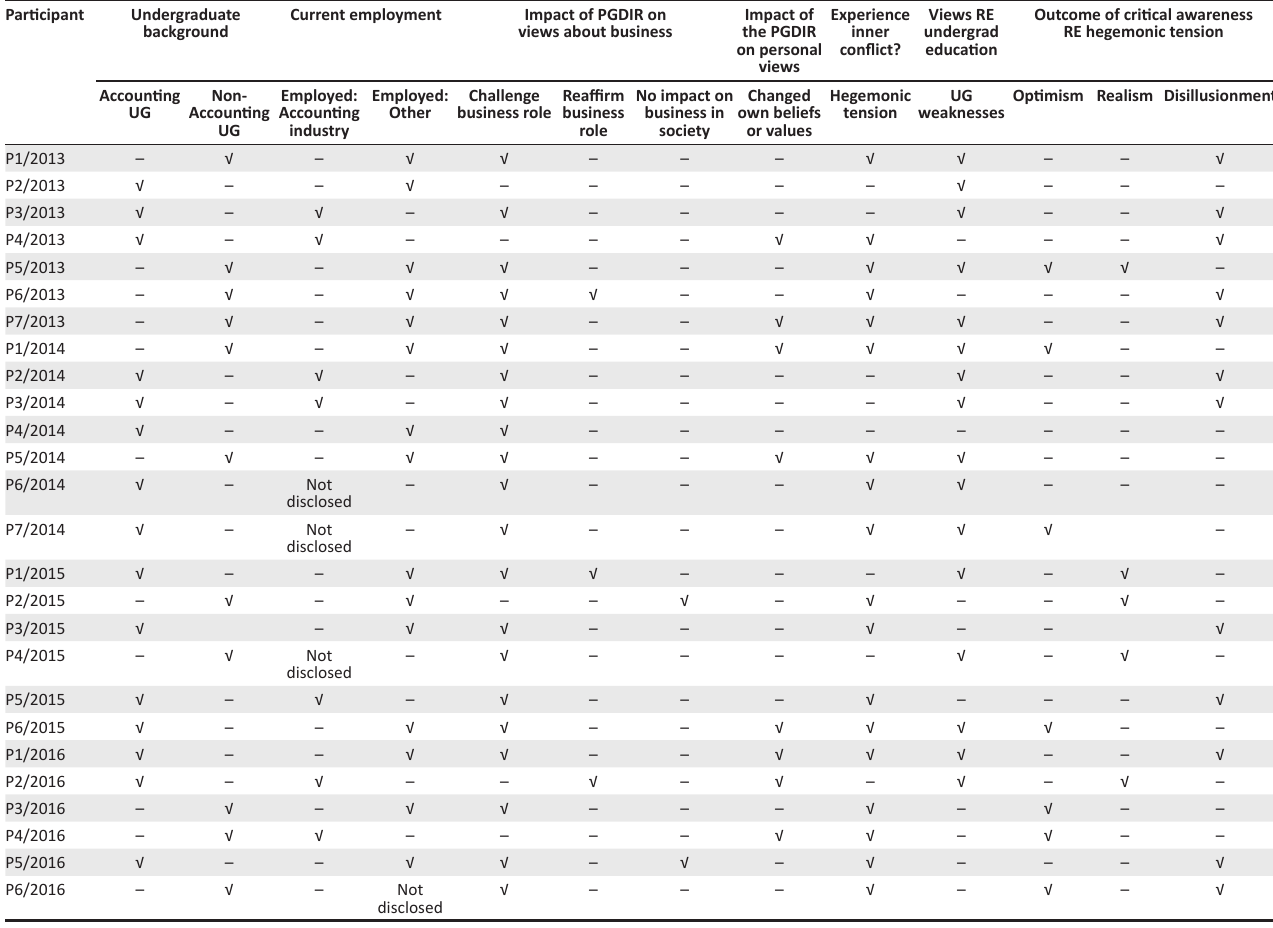
TABLE 2: Summary of findings per